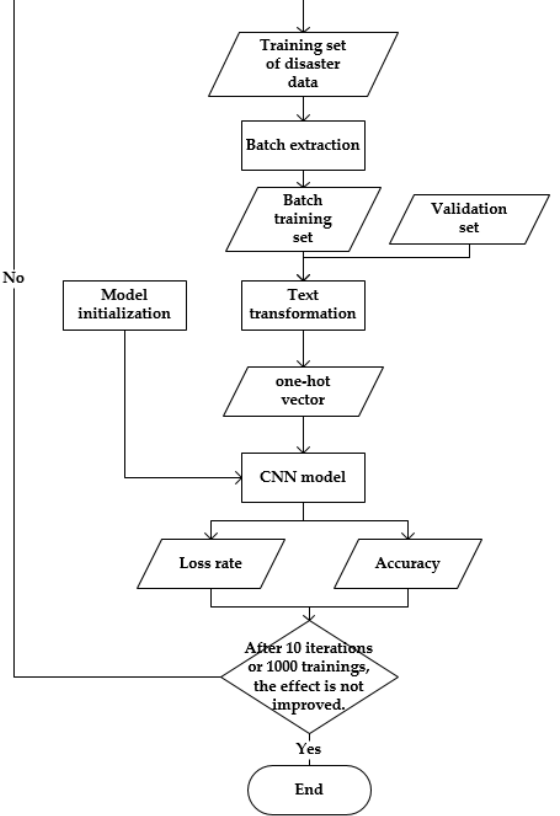
Figure 6. Training process.